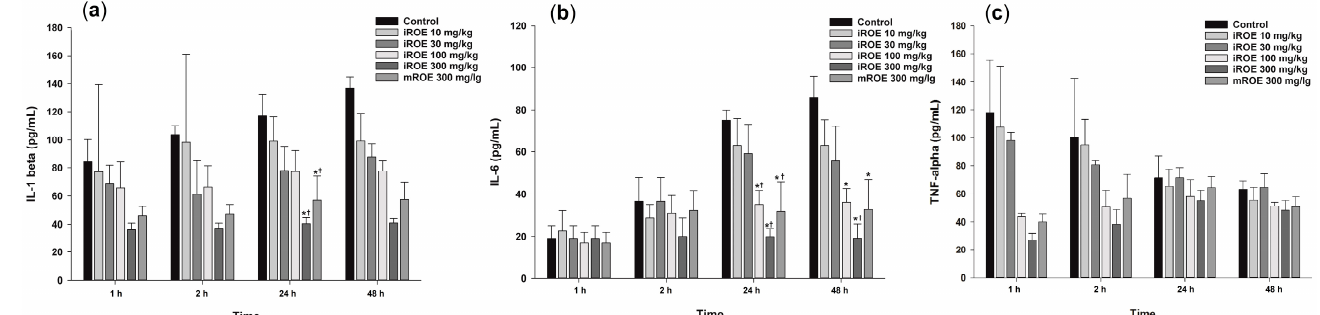
Figure 5. ( a ) Effect of immature R. occidentalis on IL- β , ( b ) effect of immature R. occidentalis on IL-6, and ( c ) effect of immature R. occidentalis on TNF- α ; * p < 0.05 compared with the control group and † p < 0.05 compared with iROE 10 mg/kg group. IL, interleukin; TNF, tumor necrosis factor; iROE, immature Rubus occidentalis extract; mROE, mature Rubus occidentalis extract.